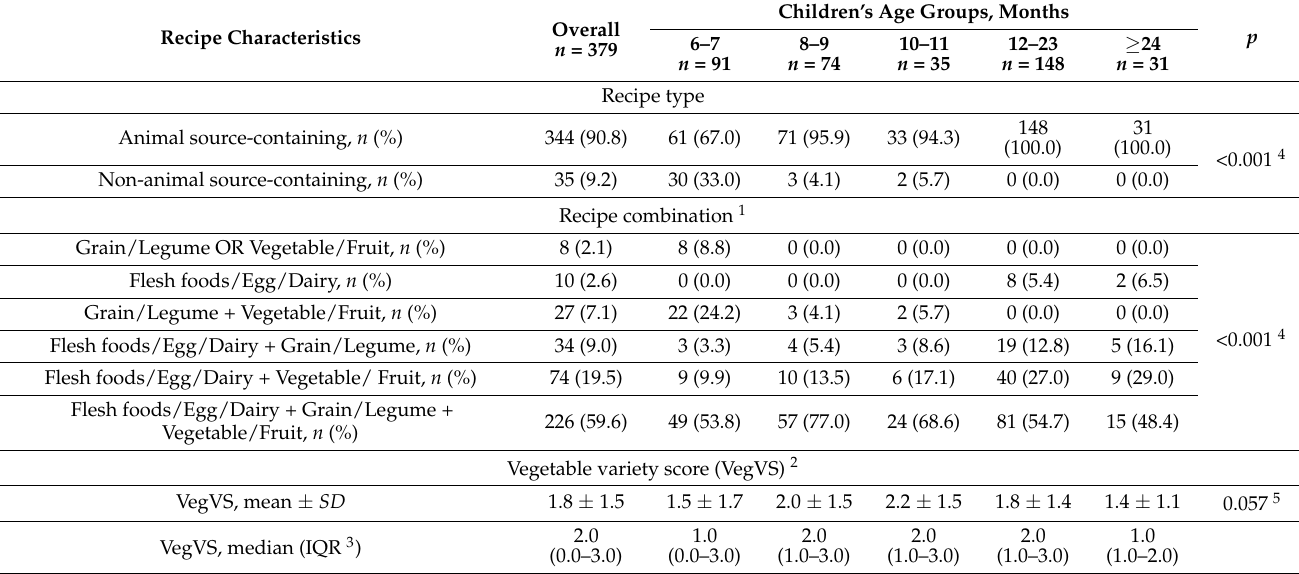
Table 1. Characteristics of shared recipes by children’s age